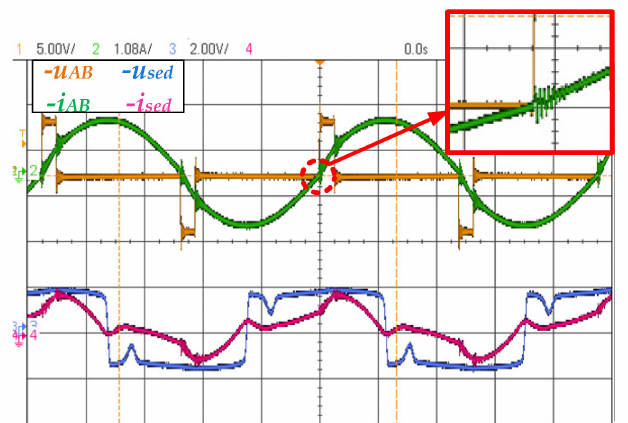
Figure 26. Waveforms of the current and voltage on the primary and secondary sides when the auxiliary circuit can just make the MOSFETs achieve soft